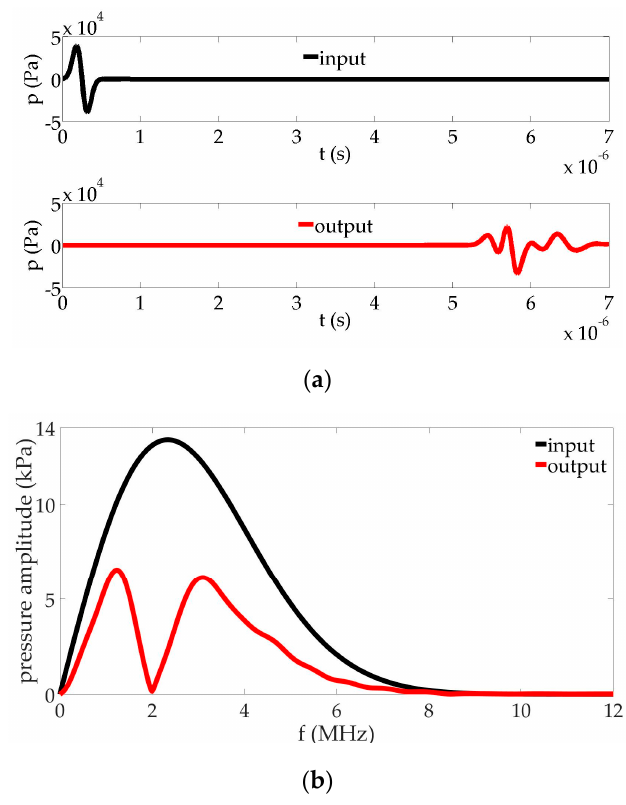
Figure 2. Comparison of input and output signals in the configuration given in Figure 1: ( a ) waveform; ( b ) frequency content.